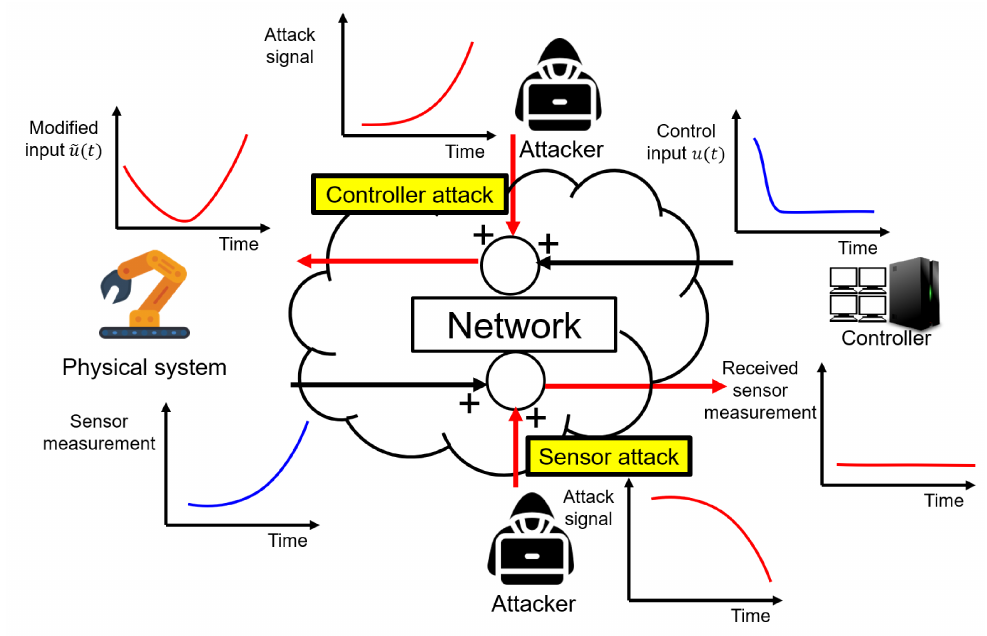
Figure 3. Cyber-physical attacks in physical system